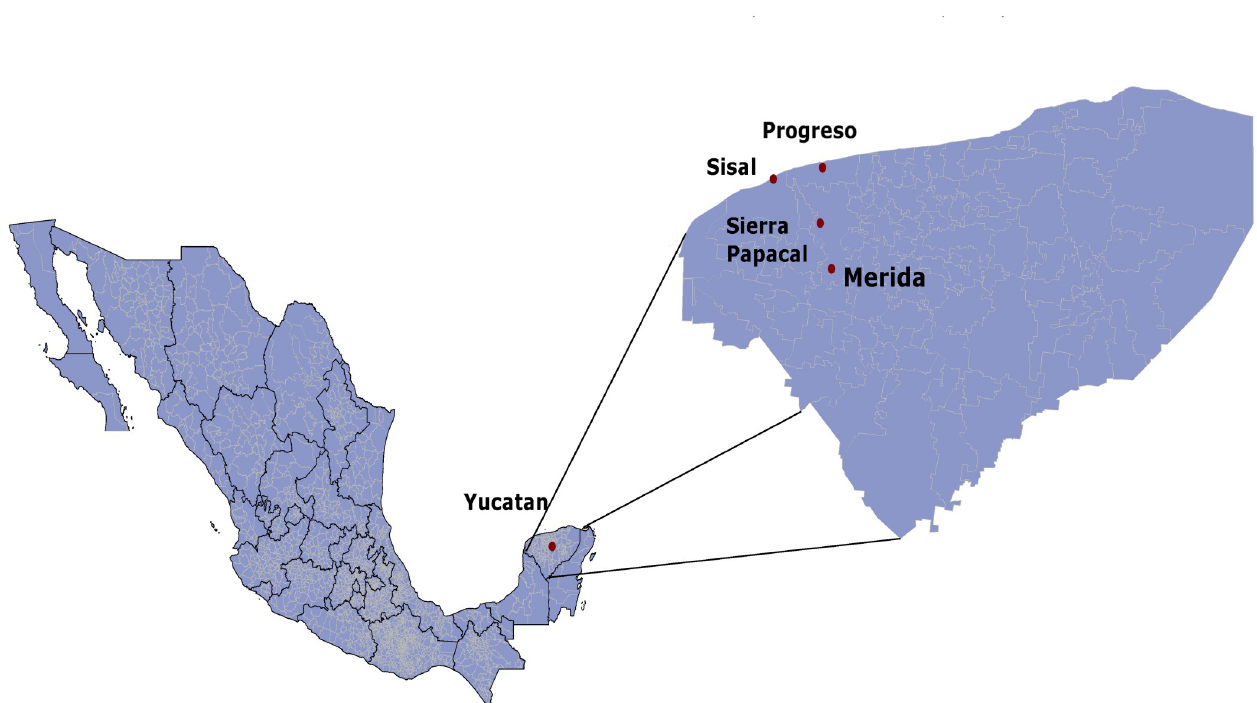
Fig 2. Climate map of the state of Yucatan. The map shows the locations of the measurements. Progreso and Sisal are coastal cities, whereas Sierra Papacal and Merida are not. According to the Ko¨ppen climate classification modified by Garcı´a [33], Merida has an Aw2 climate (sub-humid warm), Sierra Papacal is BS1 (semi-arid very warm), and Progreso and Sisal are BS0 (arid very warm).